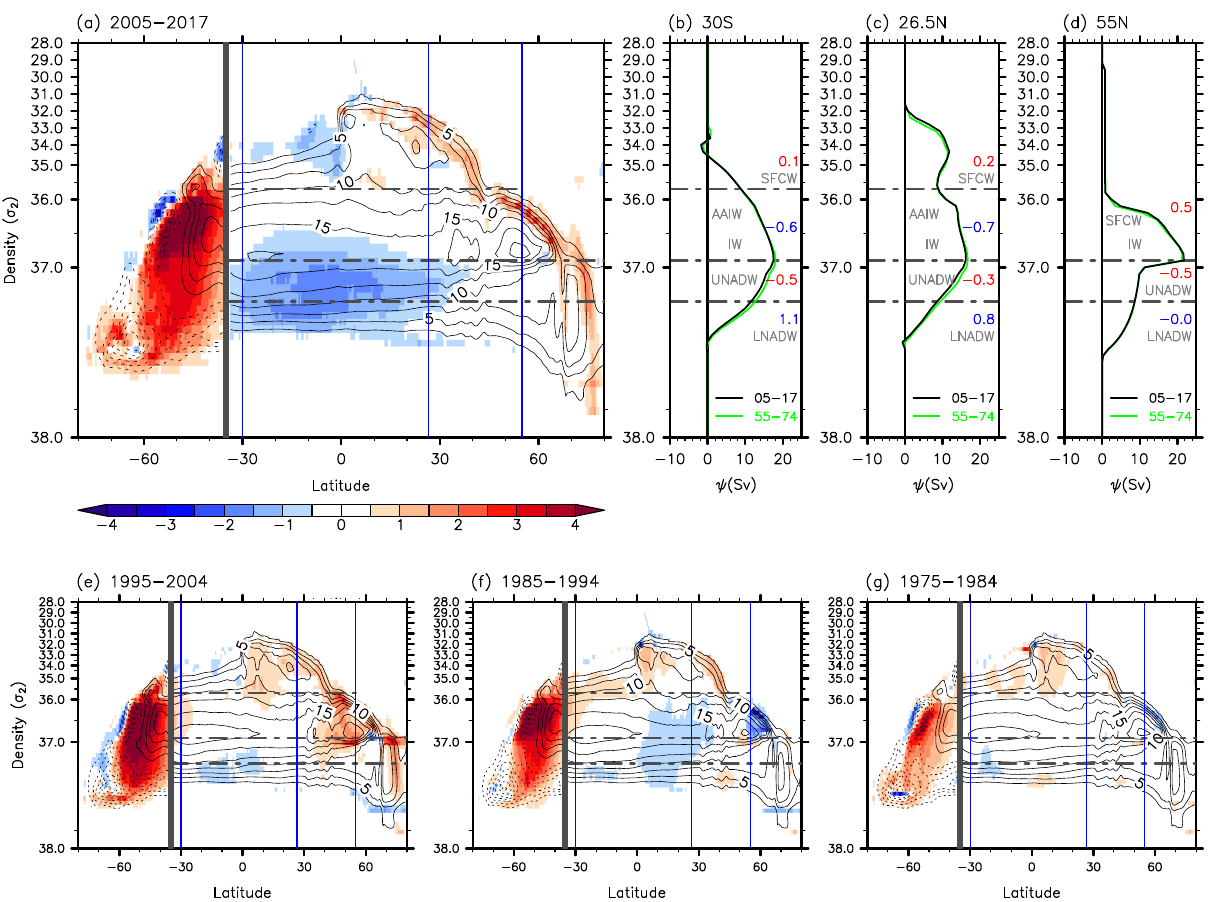
Fig. 2 The GMOC and its interdecadal changes in the Atlantic and Southern Oceans. The GMOC volume transport streamfunction (contours) in the Southern Ocean (south of 35°S) and the Atlantic Ocean (north of 35°S) and its changes (shades) during a 2005 – 2007, e 1995 – 2004, f 1985 – 1994, and g 1975 – 1984 in reference to the base period of 1955 – 1974. The AMOC volume transport streamfunction at b 30°S, c 26.5°N and d 55°N during 2005- 2007 (black lines) and 1955 – 1974 (green lines). The vertical axis is potential density in reference to 2000 m ( σ 2 units). The differences in AMOC volume transport values between 2005 – 2017 and 1955 – 1975 for SFCW, AAIW, IW, UNADW and LNADW are shown at b 30°S, c 26.5°N, and d 55°N. Red colored are for the increased transport values, and blue colored are for the decreased transport values. Black-dotted lines indicate the density ranges of water masses. Volume transports are in Sv